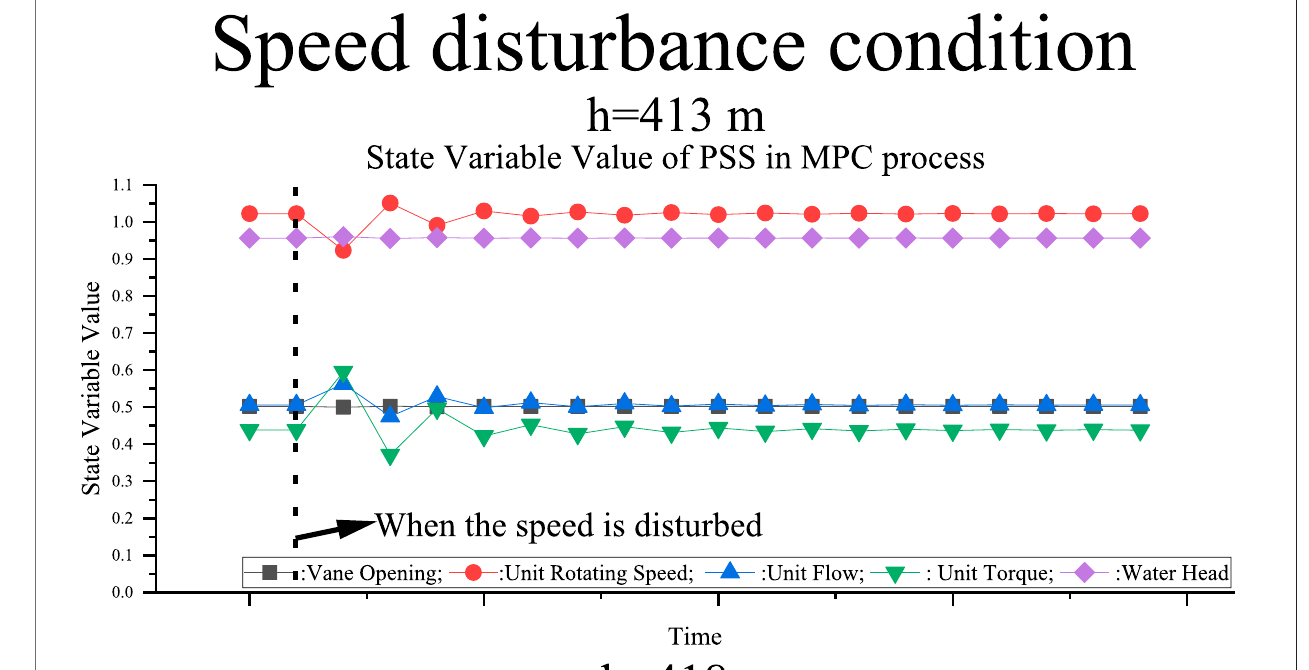
FIGURE 14 | PSS MPC state variables in the presence of speed disturbances under 413 and 418 m of water head.